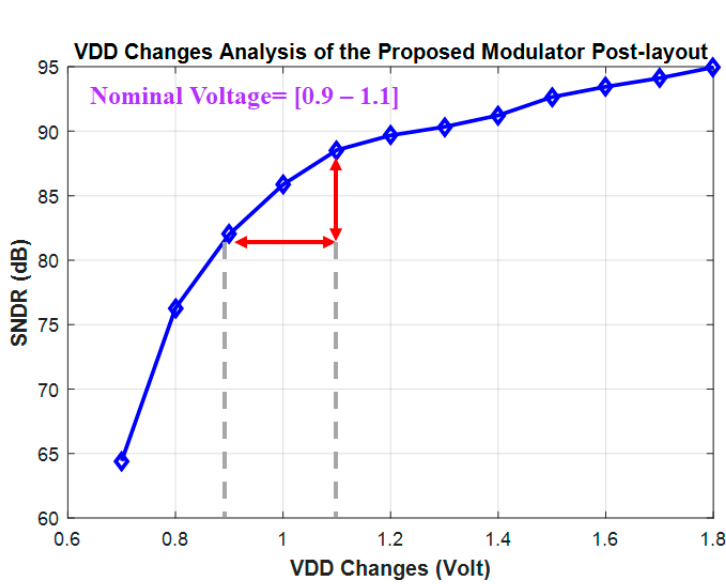
Figure 24. The power supply and nominal voltage analysis of the proposed modulator.